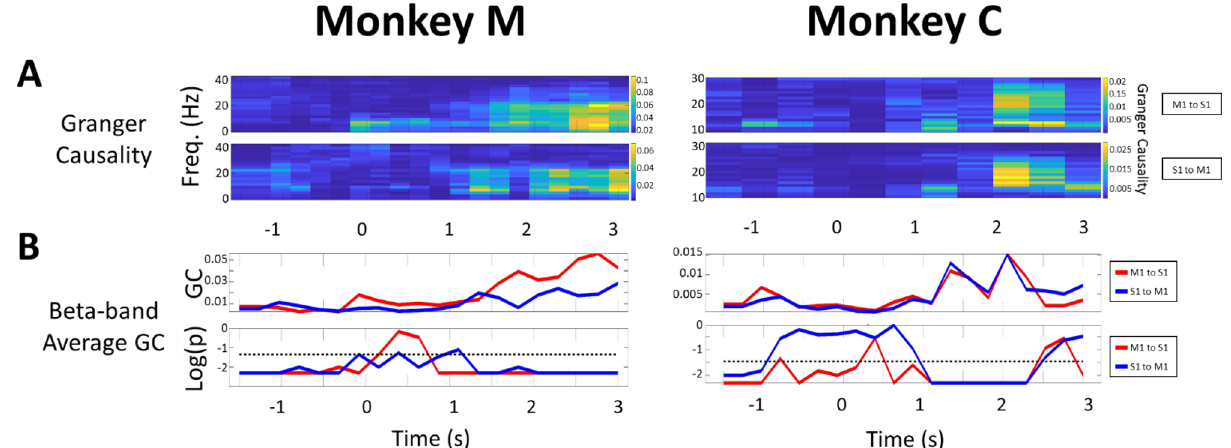
Figure 3. Example of Granger Causality of a single S1-M1 LFP channel pair revealed bidirectional communication between the two cortical areas during the ‘NORMAL’ task. All trials are aligned to the onset of touch (t = 0). Left: Monkey M. Right: Monkey C. Data for the selected channel pair was averaged across all trials (n = 51 for monkey M and n = 86 for monkey C). ( A ) Spectra-temporal S1–M1 LFP Granger causality (GC) heat map shows a bidirectional beta-band relationship between S1 and M1 for both monkeys. Causality increased significantly and reached its maximum during the steady-state. Upper panel: GC index for M1 → S1. Lower panel: GC index for S1 → M1. ( B ) Upper panel: Beta-band (15–30 Hz) averaged GC of a single LFP pair showed distinct dynamics and directionality across the four distinct stages of the task; Red trace for M1 → S1, Blue trace for S1 → M1). The GC indices are low in the ‘Planning’, Moving’, and ‘Touching’ stages but increase rapidly when the animal reached the steady-state hand squeeze. Lower panel: p-value on log 10 scale calculated from a random permutation test (# permutations = 200). We chose a target α = 0.05 and used FDR correction for multiple testing. The black dashed line represents the log of adjusted α. Those GC indices with p-value above the dashed line were considered as statistically not